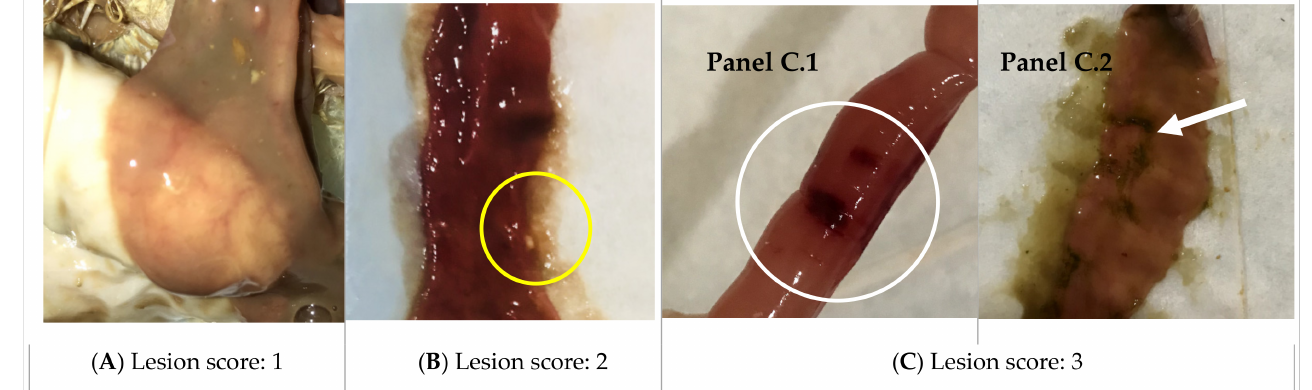
Figure 6. Necrotic enteritis lesions. ( A ) Score 1: intestine is thin and friable; ( B ) Score 2: the picture shows the thin, friable intestine with a small patch of necrosis (yellow circle). There is also redness in the intestinal tract, and some gray mucus is characteristic; ( C ) Score 3: the intestine shows a larger lesion visible through the outer wall of the intestinal tract. There are larger patches of necrosis (white circle and arrow), which are the green areas stained by bile. Panel C.1 shows the closed tube and panel C.2 shows the open tube and exposed inner side